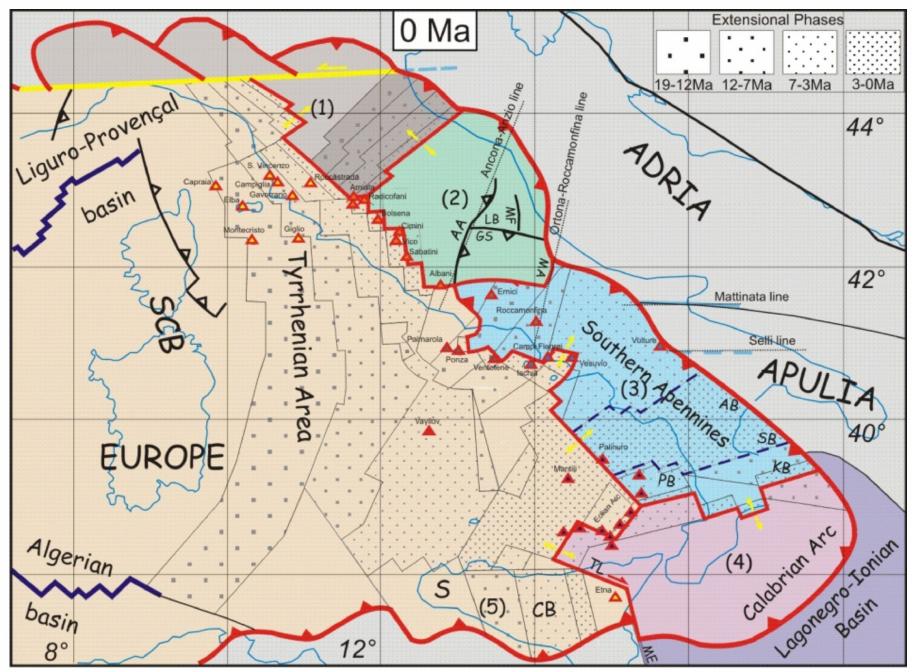
Figure 28. Plate reconstruction of the western Mediterranean region at 0 Ma. Triangles are volcanoes: the Tuscan province is in filled in ( yellow ), the Roman province is in orange, the Campanian province is in ( blue ), the Aeolian Arc with Marsili and Palinuro is in ( black ). The Northern Sector ( 1 ) is shown in ( dark beige ); the Central Sector ( 2 ) is in ( green ); the Southern Sector ( 3 ) is in ( light blue ); the Calabrian Arc Sector ( 4 ) is in ( pink ), the Sicilian Sector in ( light green ) ( 5 ). ( Dotted areas ) are in extension (see upper right legend). ( Red lines ) are active boundaries. ( Black lines ) are inactive boundaries. ( Yellow lines ) are strike-slip faults. ( Light blue lines ) transfer faults on the continental lithosphere. ( Dark blue lines) are the Middle-Triassic COB and transfer faults on the continental lithosphere. Blue dashed lines identify the area of the Southern Apennine exhumed from 7 Ma. A-A: Ancona-Anzio line; AB: St. Arcangelo Basin; CB, Caltanissetta Basin, KB: Crotone Basin; GS: Gran Sasso Front; LB: Laga Basin; MA: Maiella Front; MF: Montagna dei Fiori; PB: Paola Basin; S: